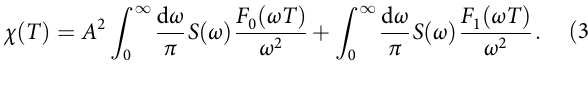
Geometric-phase magnetometry in nonadiabatic regime .